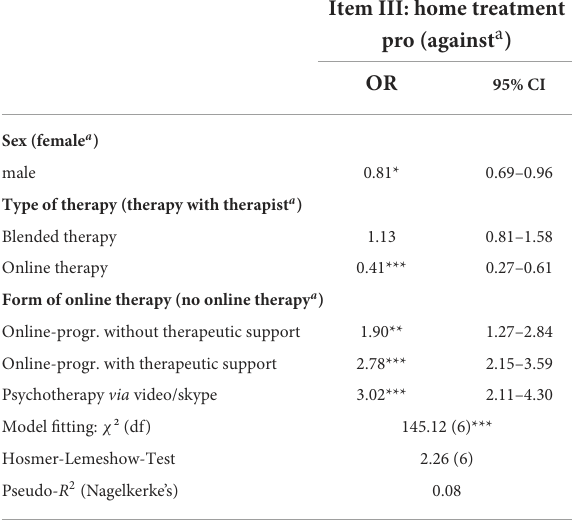
TABLE 4 Factors associated with attitudes toward home treatment: binary logistic regression. Item III: home